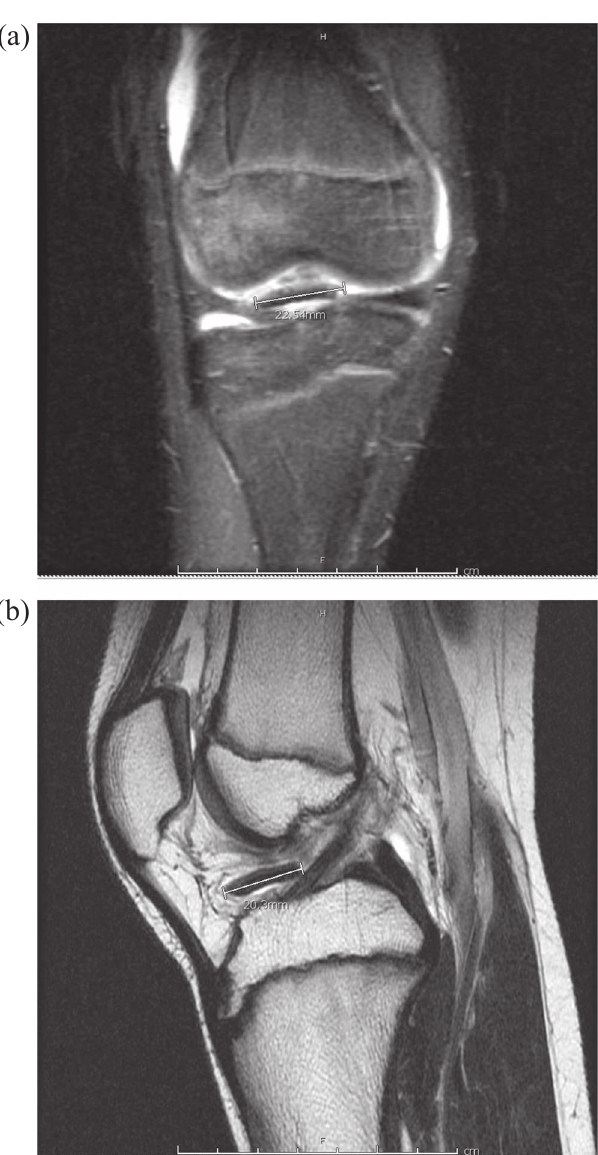
Figure 2. T2- and T1-weighted MRI demonstrating large chondral fragment within the intercondylar notch (a and